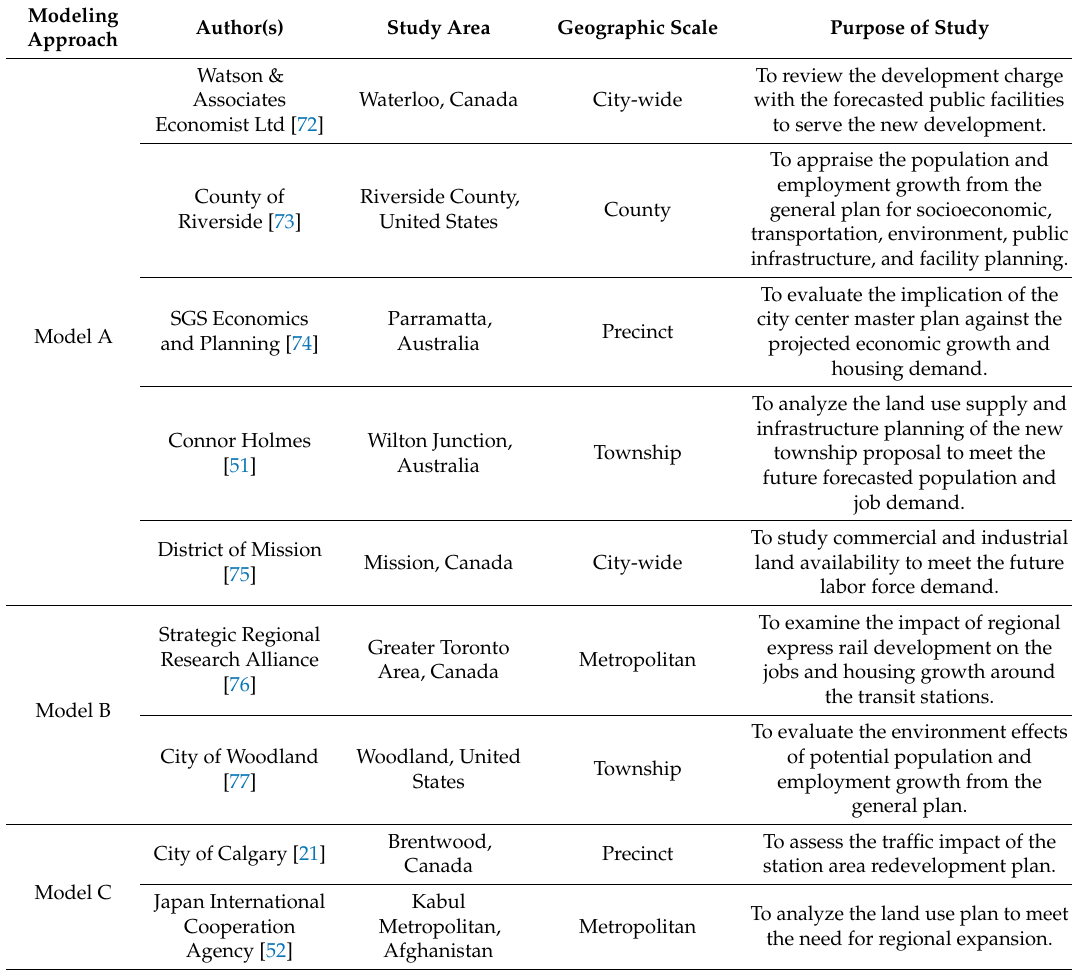
Table 2. Summary of modeling approaches and present population and employment forecasting studies using building floor